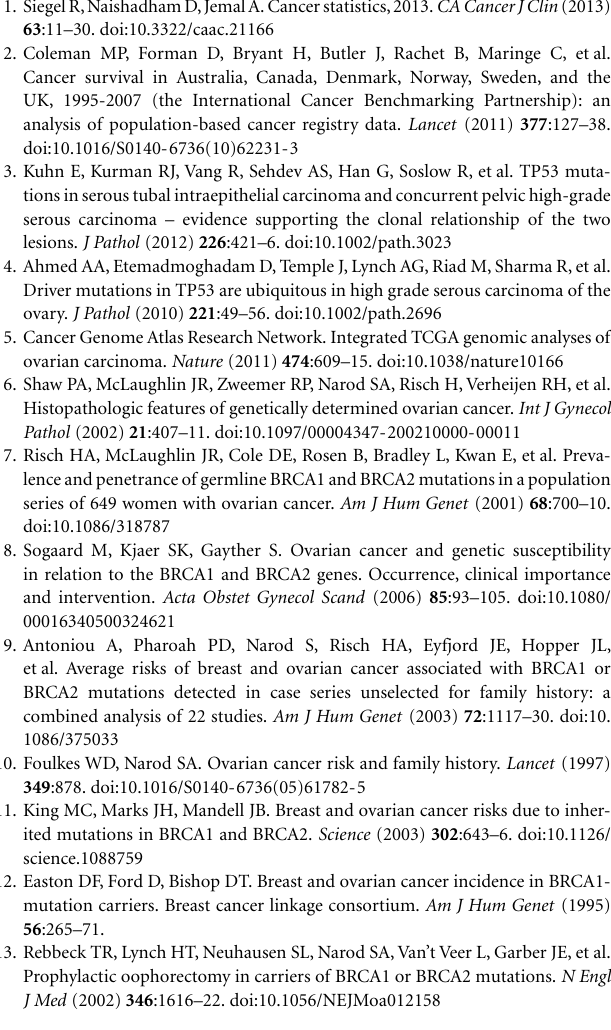
(90). In contrast, 70–80% of HGSC patients express ER α ( >